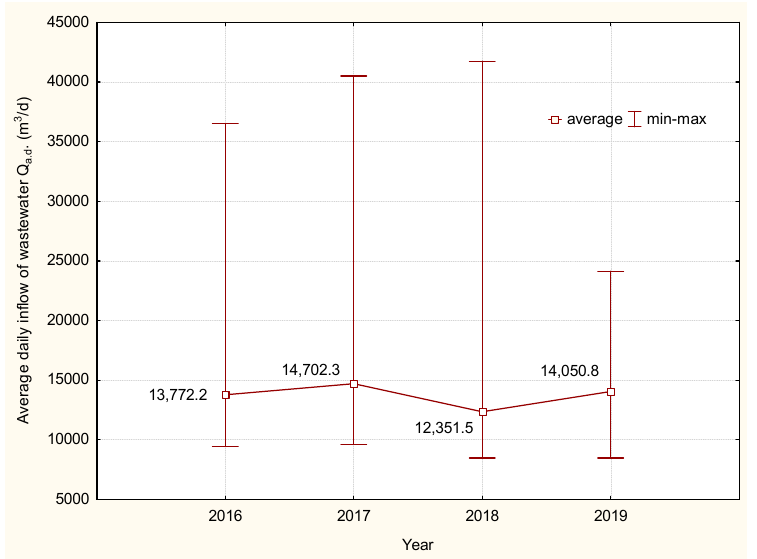
Figure 2. Daily average and extreme daily inflows of municipal wastewater and accidental water to the wastewater treatment plant in Nowy Targ.